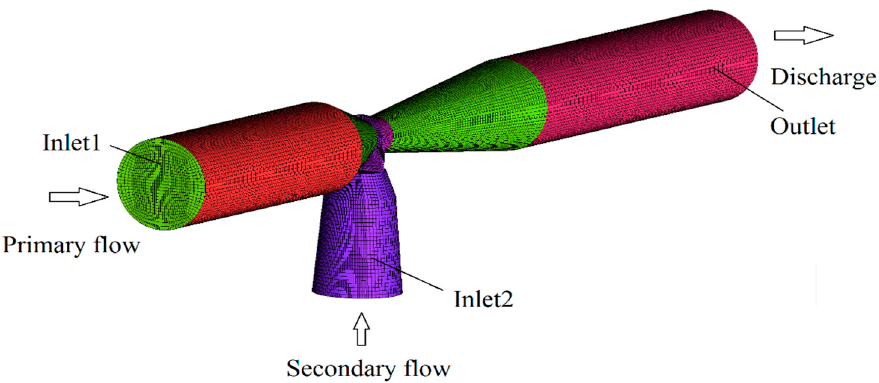
Figure 3. Computational grids and boundary conditions.